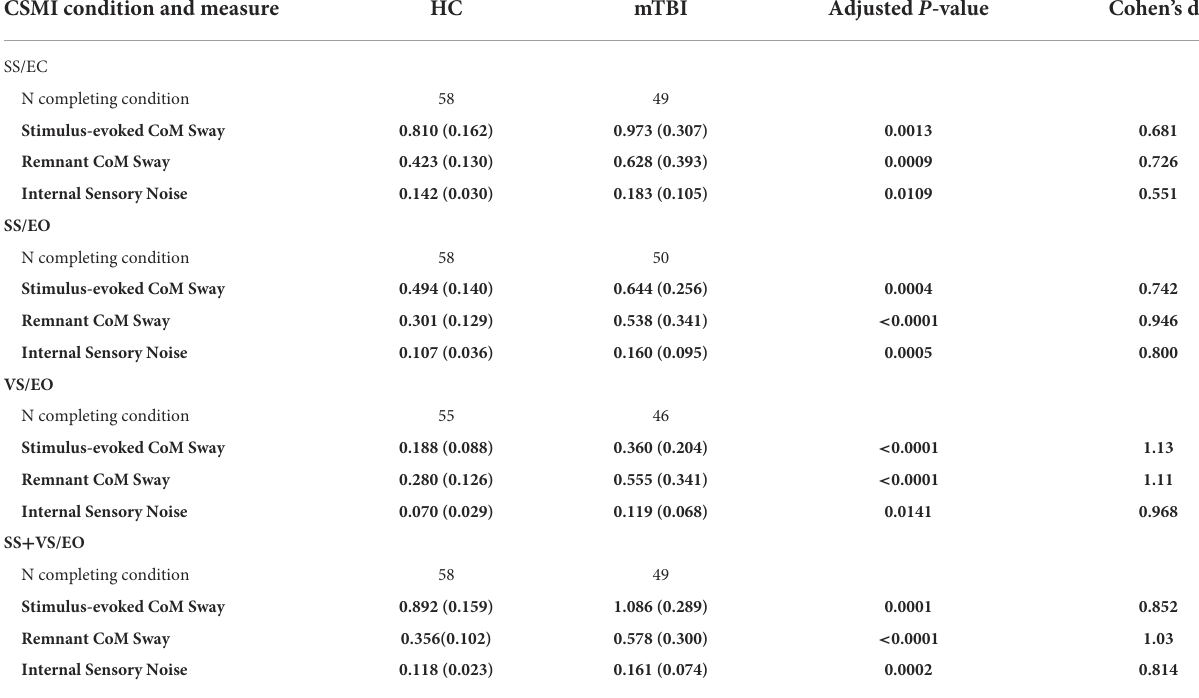
TABLE 2 RMS values of stimulus-evoked CoM sway, remnant CoM sway, and internal sensory noise for healthy controls (HC) and chronic mild traumatic brain injury (mTBI) groups. CSMI condition and measure HC mTBI Adjusted P -value Cohen’s d